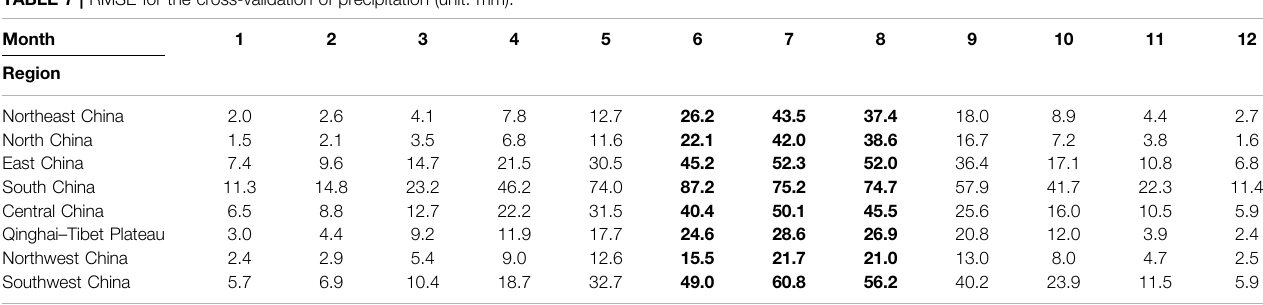
TABLE 7 | RMSE for the cross-validation of precipitation (unit: